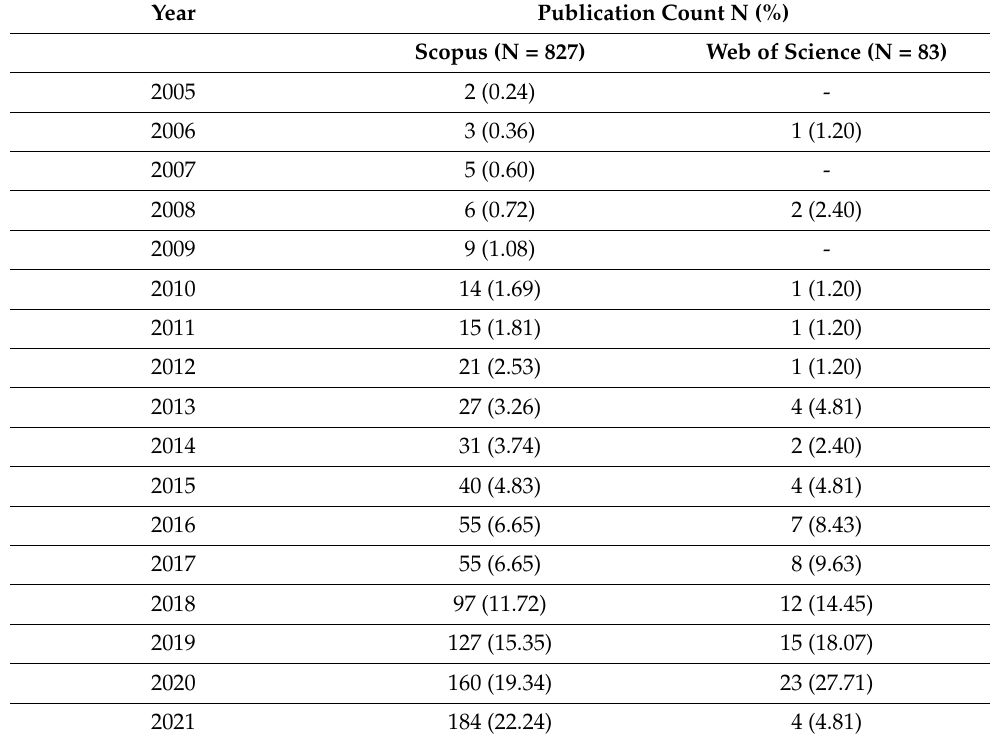
Figure 5. Number of Publications per Year (2005–2021) on text-based emotion detection using artificial intelligence. Table 7. Yearly Publication Count from Scopus and Web of